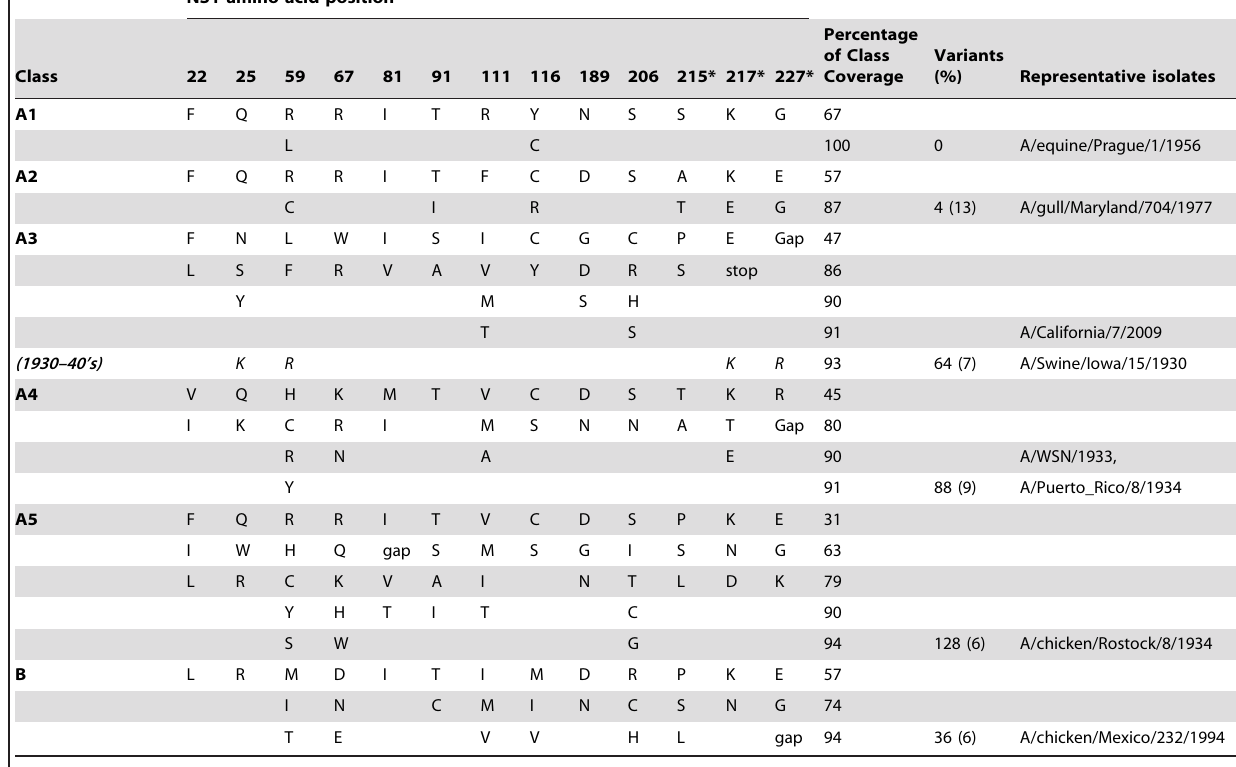
Table 3. Thirteen amino acid residues used to classify NS1 sequences.